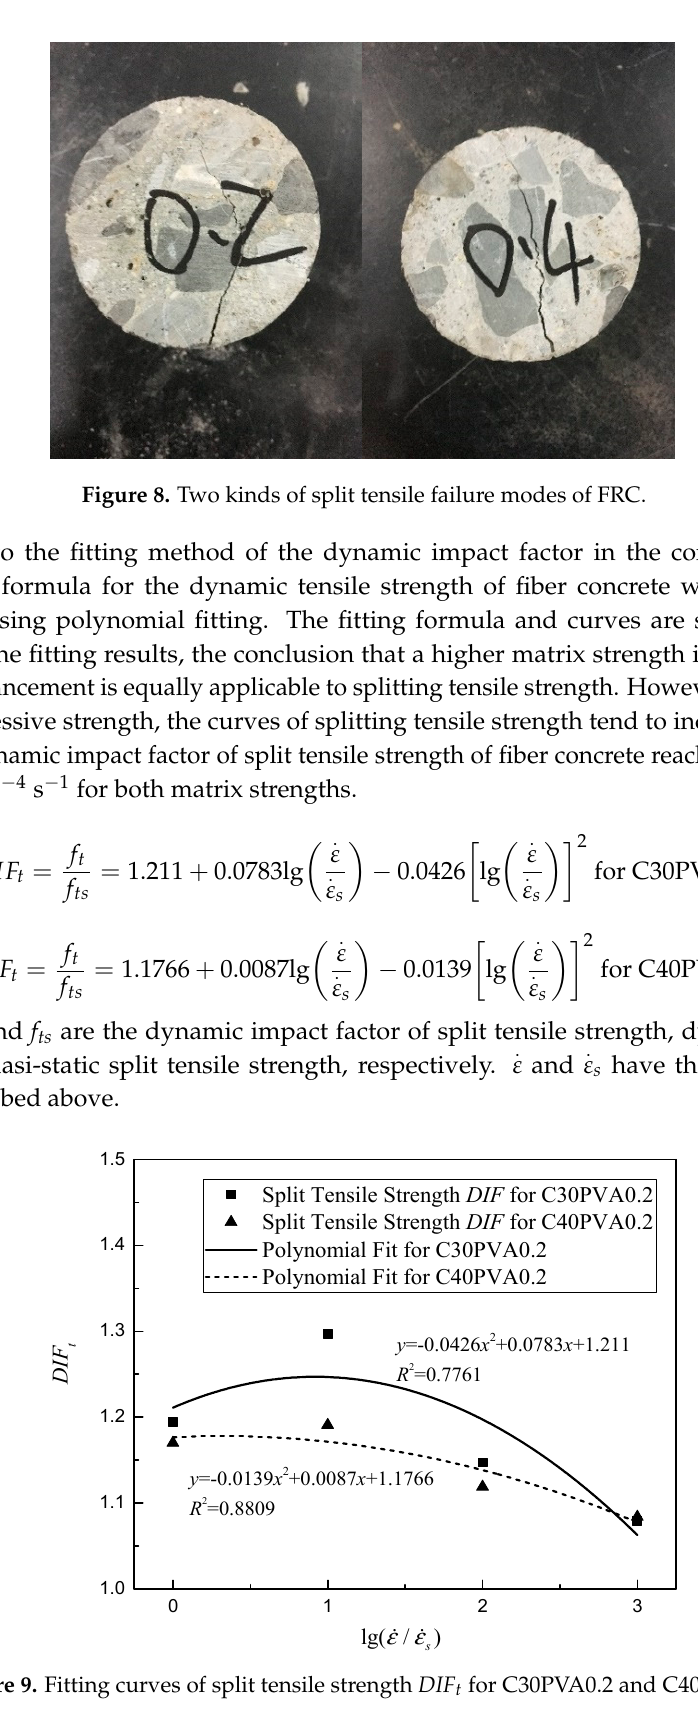
Figure 9. Fitting curves of split tensile strength DIF t for C30PVA0.2 and C40PVA0.2.